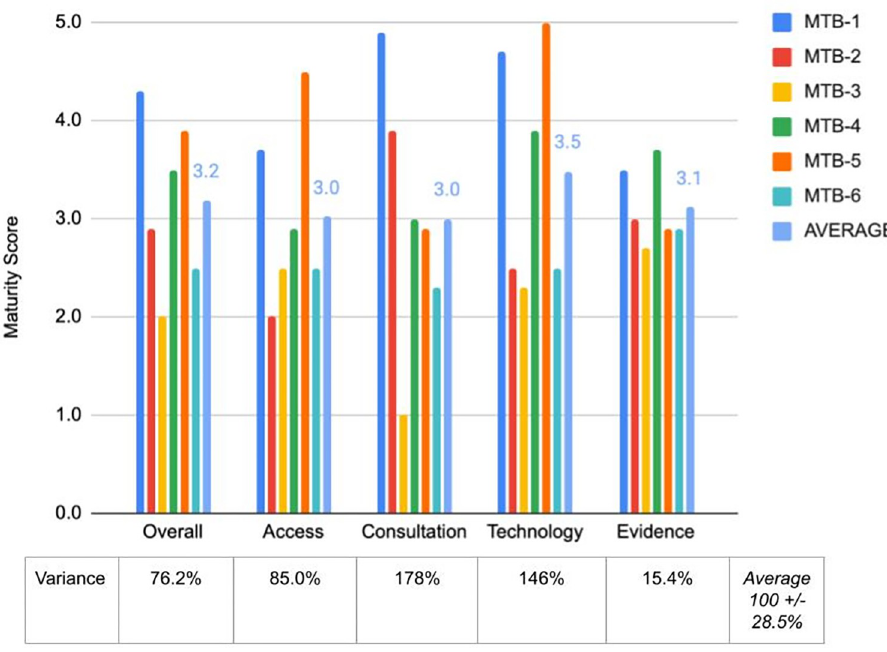
Fig 2. Overall and domain-specific maturity scores for 6 MTBs used for Phase 2 validity testing. MTBs 1–6 correspond to the 6 MTBs in the exact order presented in Table 2. Individual and average domain-specific and overall maturity scores were plotted on a scale from 0 to 5.0. % Variance from the mean is shown for the 6 maturity scores in each category and averaged across the categories with a standard error.